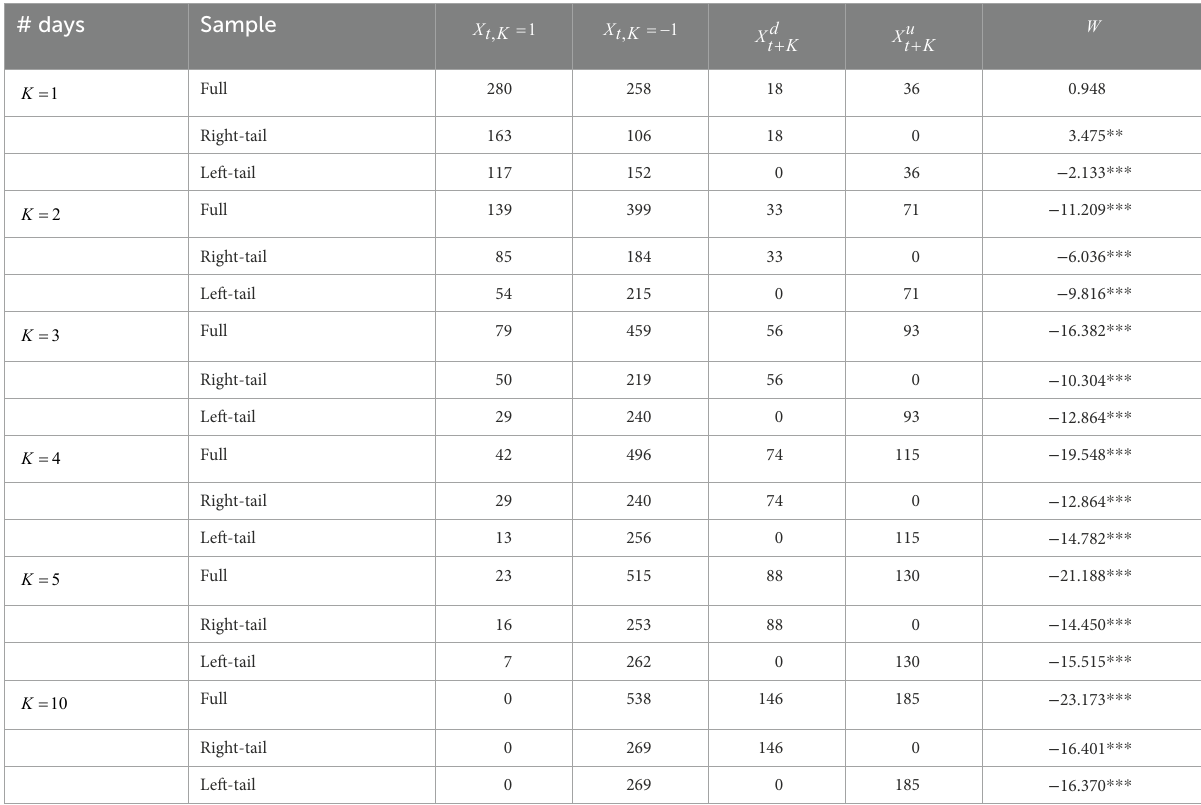
TABLE 1 Statistics on the relationship between big booms and big falls in the stock market. #